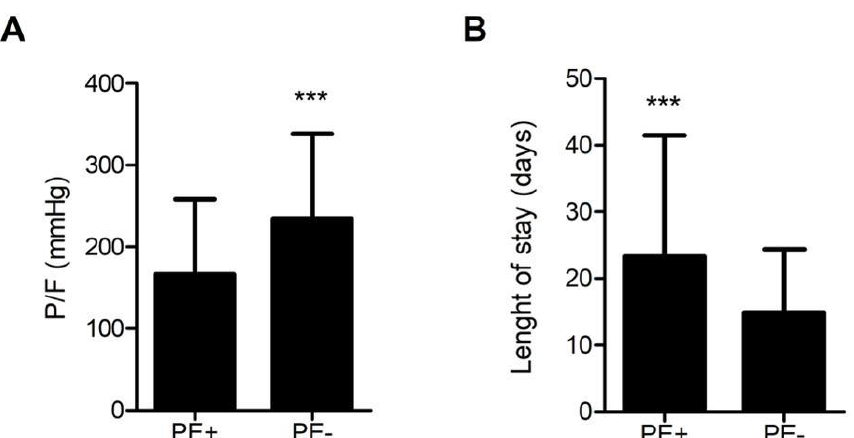
Figure 1. PaO 2 /FiO 2 (P/F) for PE + and PE − patients. *** p < 0.001 by Student’s t -test ( A ); length of